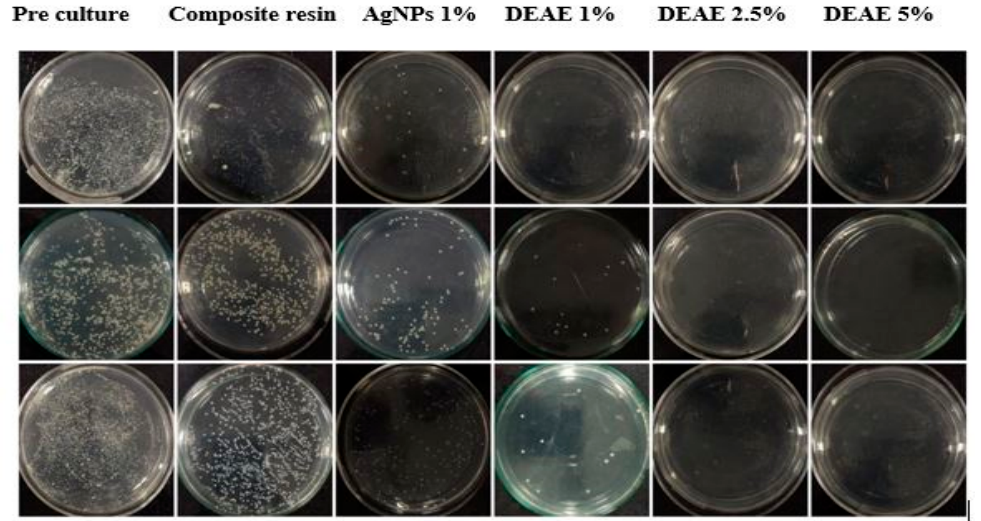
Figure 5. Bacterial colonies on TSA plates.